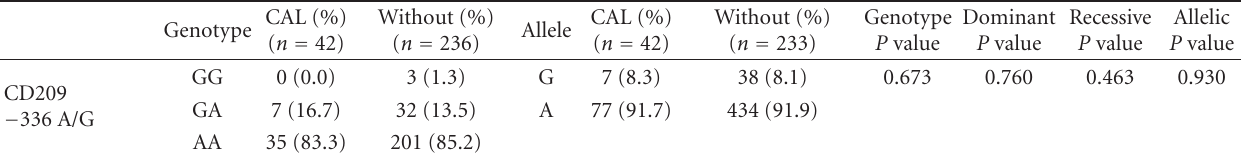
Table 3: Genotyping and allele frequency of CD209 − 336 A/G in patients with coronary artery lesion (CAL) and without CAL. CAL (%) Genotype ( n = 42)